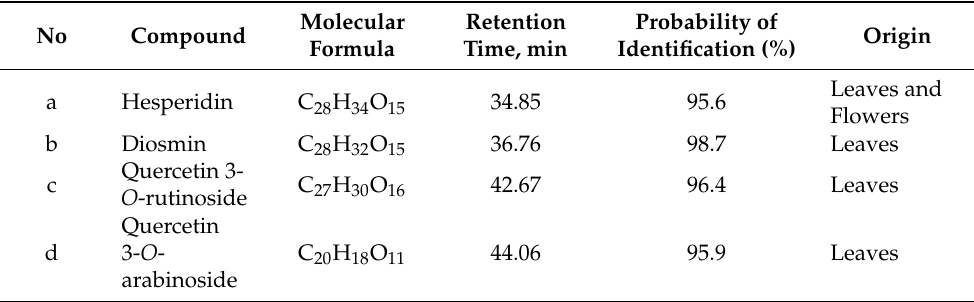
Table 1. Phytochemicals extracted from P. viscosa and identified by HPLC, LC-ESI-MS and MALDI-TOF-MS.